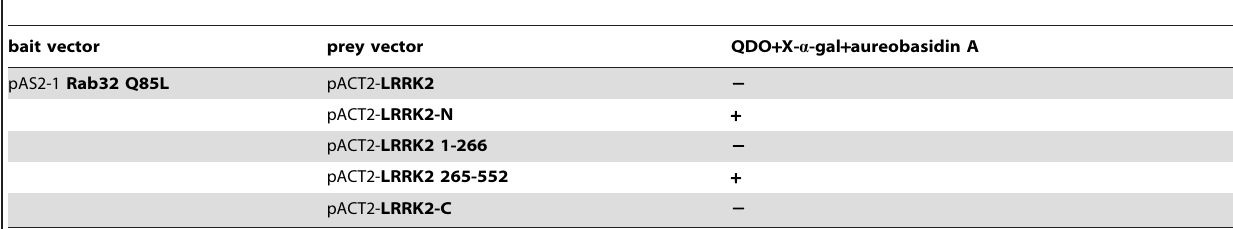
Table 2. Mapping of Rab32 binding domain within